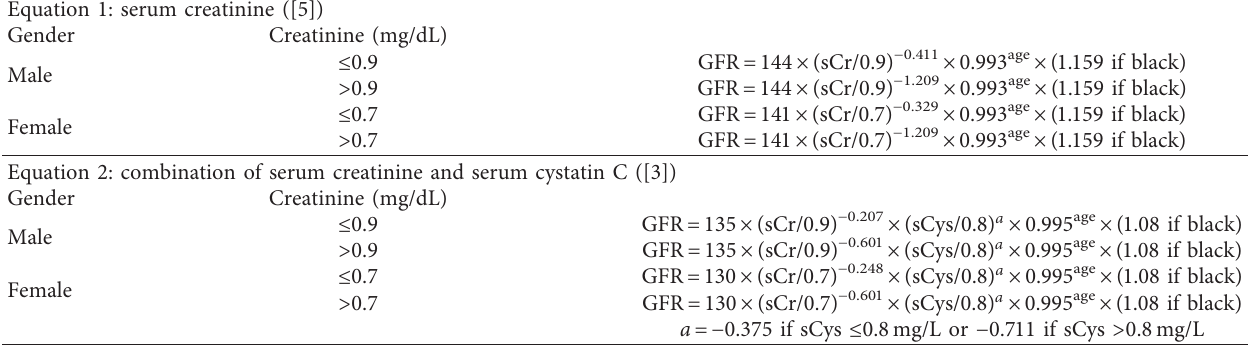
Table 1: CKD-EPI equations for GFR